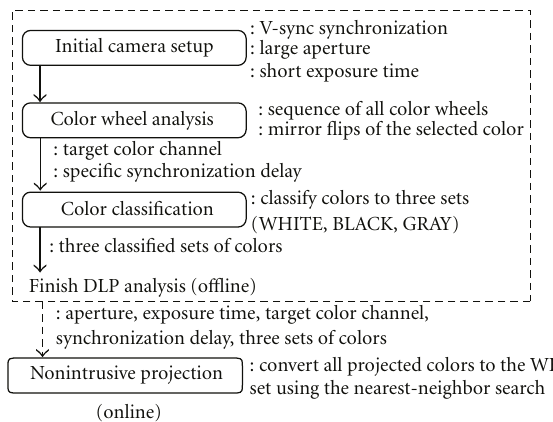
Figure 10: Procedural flow of the proposed nonintrusive projection during o ffl ine and online execution.